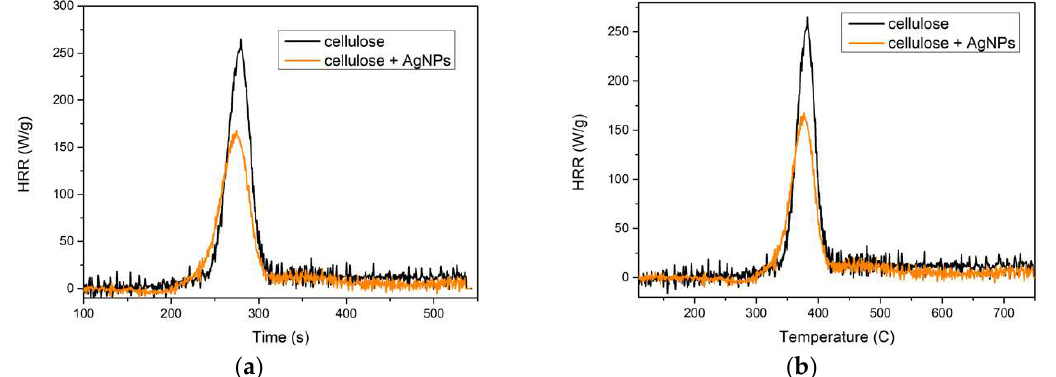
Figure 6. Heat release rate (HRR) of cellulose fibers: ( a ) time dependence, ( b ) temperature. Table 2. Flammability parameters of cellulose fibers. THR, total heat release.